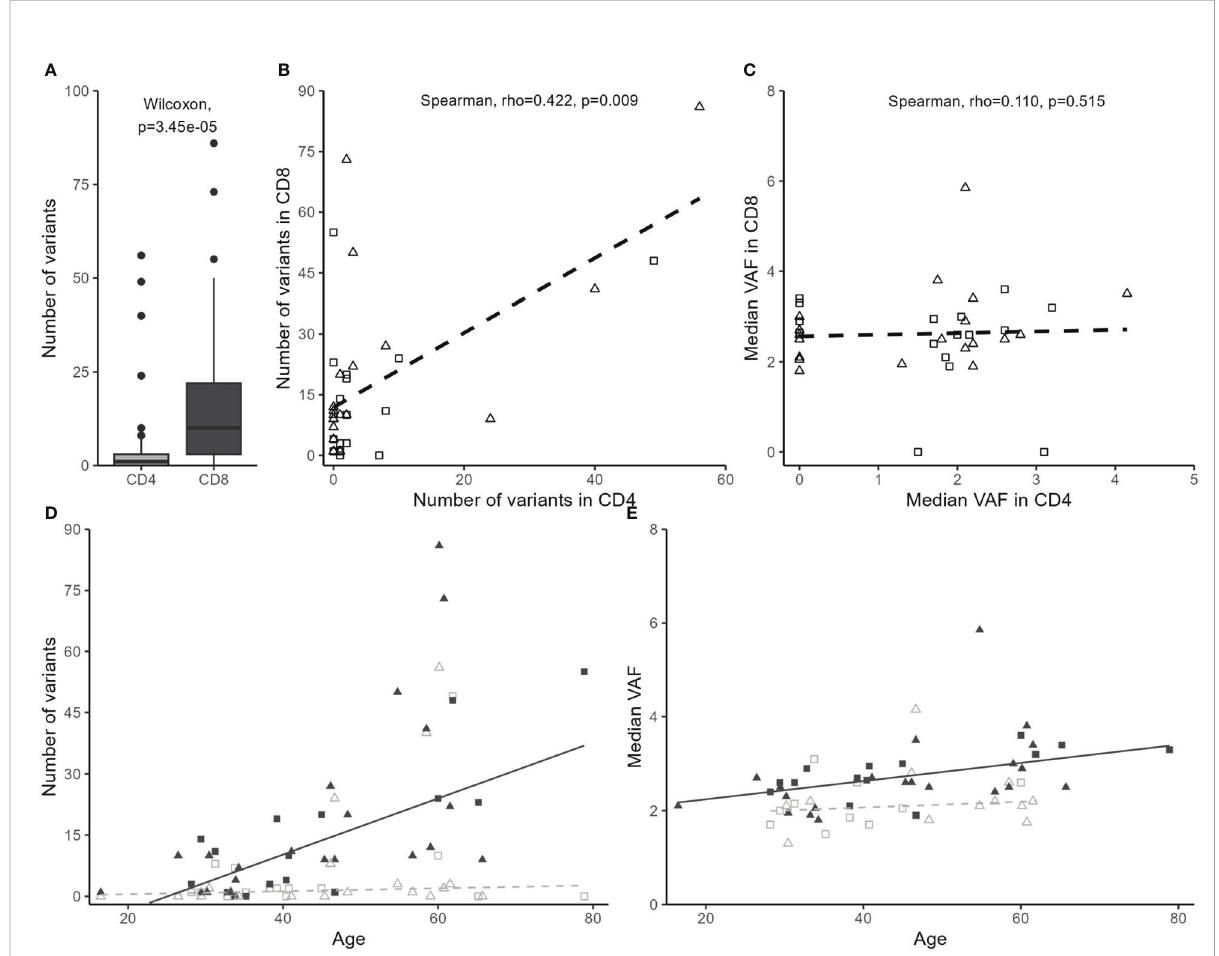
FIGURE 1 Somatic variants are more common in CD8 + than in CD4 + T lymphocytes and are correlated with the individual ’ s age. Data points from controls are depicted by squares and from individuals with MS by triangles. (D, E) Data points from the CD4 + subset are depicted in light gray and without fi ll and from the CD8 + subset in solid dark gray. Linear regression trend lines are shown. (A) Distribution of the number of somatic variants in CD4 + and CD8 + subsets. (B) Correlation between the number of somatic variants in CD4 + and CD8 + subsets. (C) Correlation between median variant allele frequency (VAF) of somatic variants in CD4 + and CD8 + subsets, with median VAF set to 0 in absence of somatic variants. (D) The number of variants in CD4 + and CD8 + T lymphocytes in correlation with the individual ’ s age [quantile (median) linear regression: the number of variants differs with cell type ( p = 0.031) and signi fi cantly increases with age in the CD8 + subset ( p = 0.001), but not in the CD4 + subset ( p = 0.697)]. (E) Median VAF of variants in CD4 + and CD8 + T lymphocytes across individuals in correlation with the individual ’ s age [quantile (median) linear regression: median VAF estimated to be 0.68% higher in the CD8 + subset ( p = 2.9 × 10 − 4 ) and to increase with 0.02% per 1-year increase in age ( p =